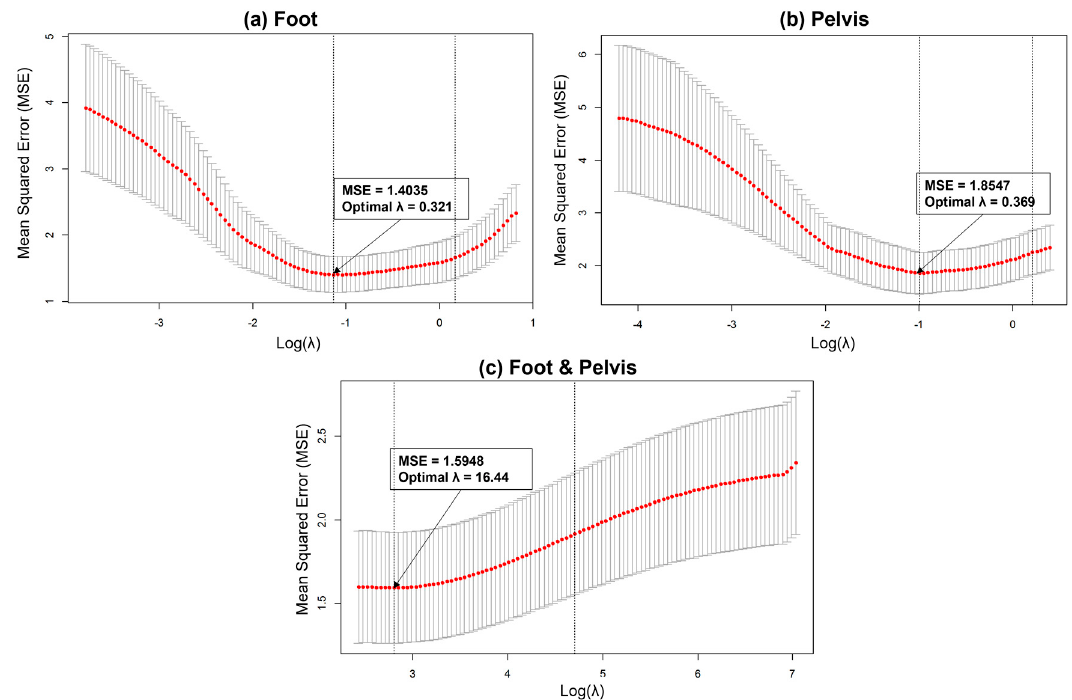
Figure 4. Optimal penalty parameter λ tuning for elastic net: ( a ) foot, ( b ) pelvis, and ( c ) foot and pelvis. The optimal λ for each model was chosen when the MSE was minimum ( λ = 0.321, 0.369, and 16.44 for foot, pelvis, and foot & pelvis, respectively).